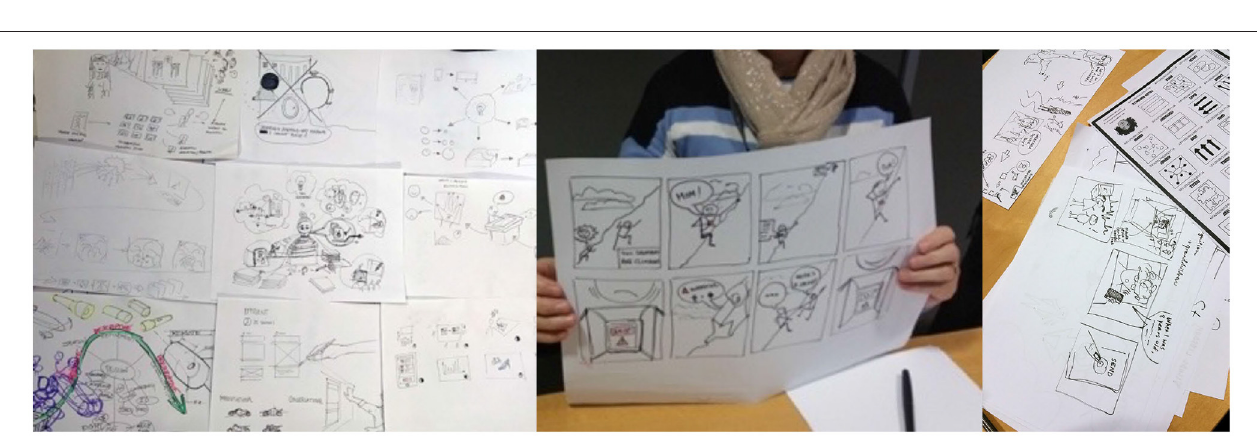
FIGURE 11 | Exemplar outputs from the Sketching in HCI workshop 2018, and courses at NordiCHI 2014, and CHI